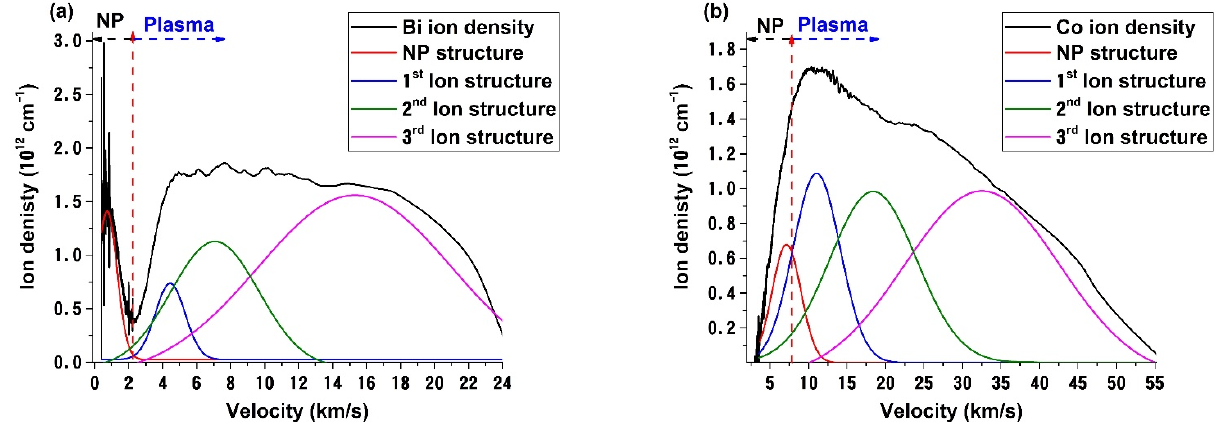
Figure 4. Deconvolution of the charge density velocity distribution of Bi ( a ) and Co ( b ) plasmas for the 10 − 5 Pa case.